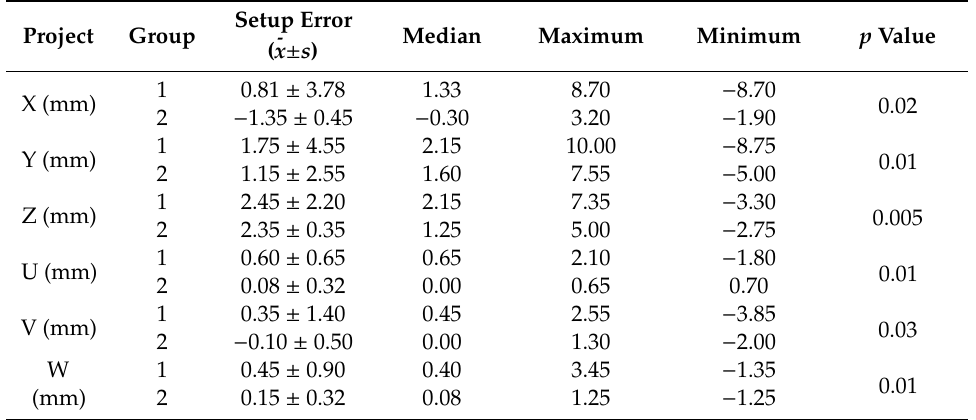
Table 5. Comparison of setup error results from vacuum pad fixation (Group 1) and thermoplastic membrane fixation (Group 2).